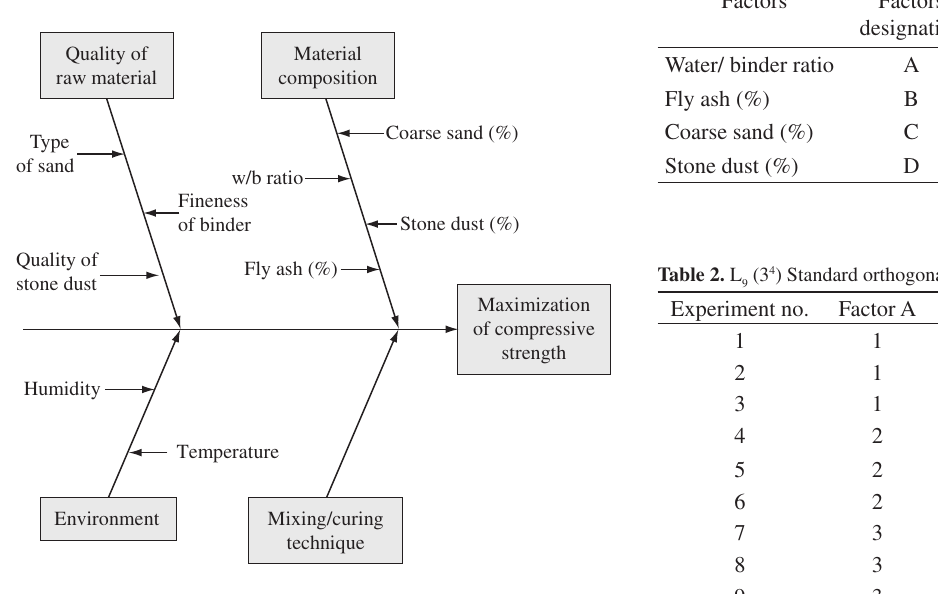
Figure 1. Cause-and-effect diagram for processing of fly ash brick.